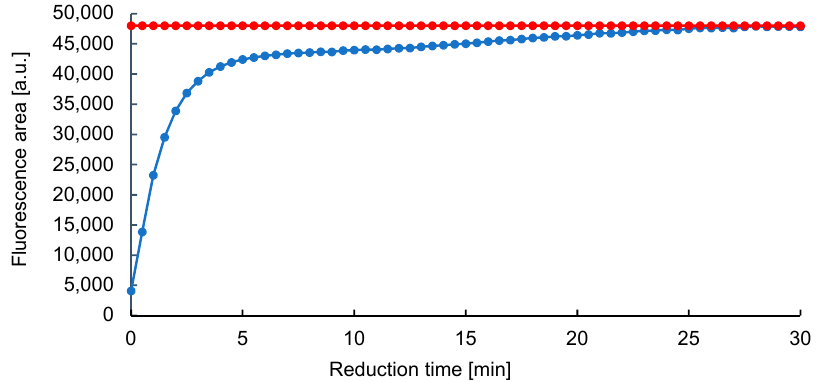
Figure 3. Integrated fluorescence as a function of time for the reduction of FN 14 to its corresponding hydroxylamine derivative 20 with 1000 equivalents of sodium ascorbate. Hydroxylamine 20 ( • ); FM 17 ( • ). Measured in H 2 O with λ ex = 340 nm.